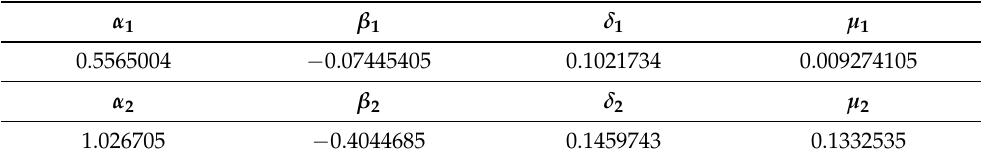
Table 5. Estimation result of the NIG part of RSLDOU model for fuel-switching